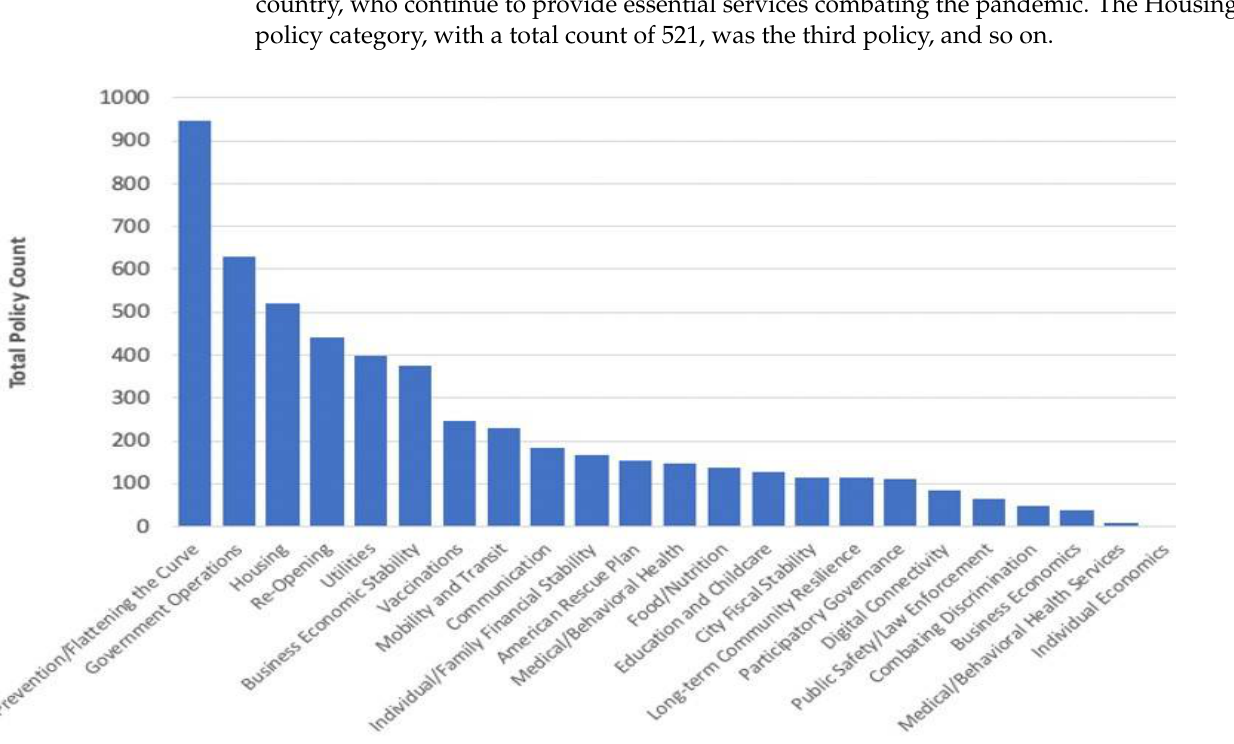
Figure 5 . Number of Public Health Policies by type during the COVID-19 Pandemic. Figure 5. Number of Public Health Policies by type during the COVID-19